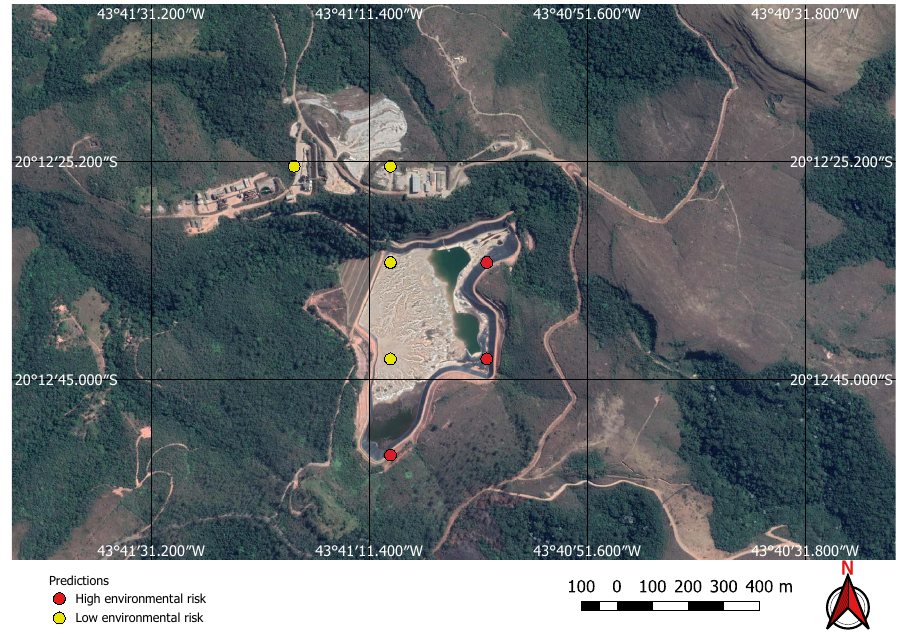
Figure 13. Small mine with potential low environmental